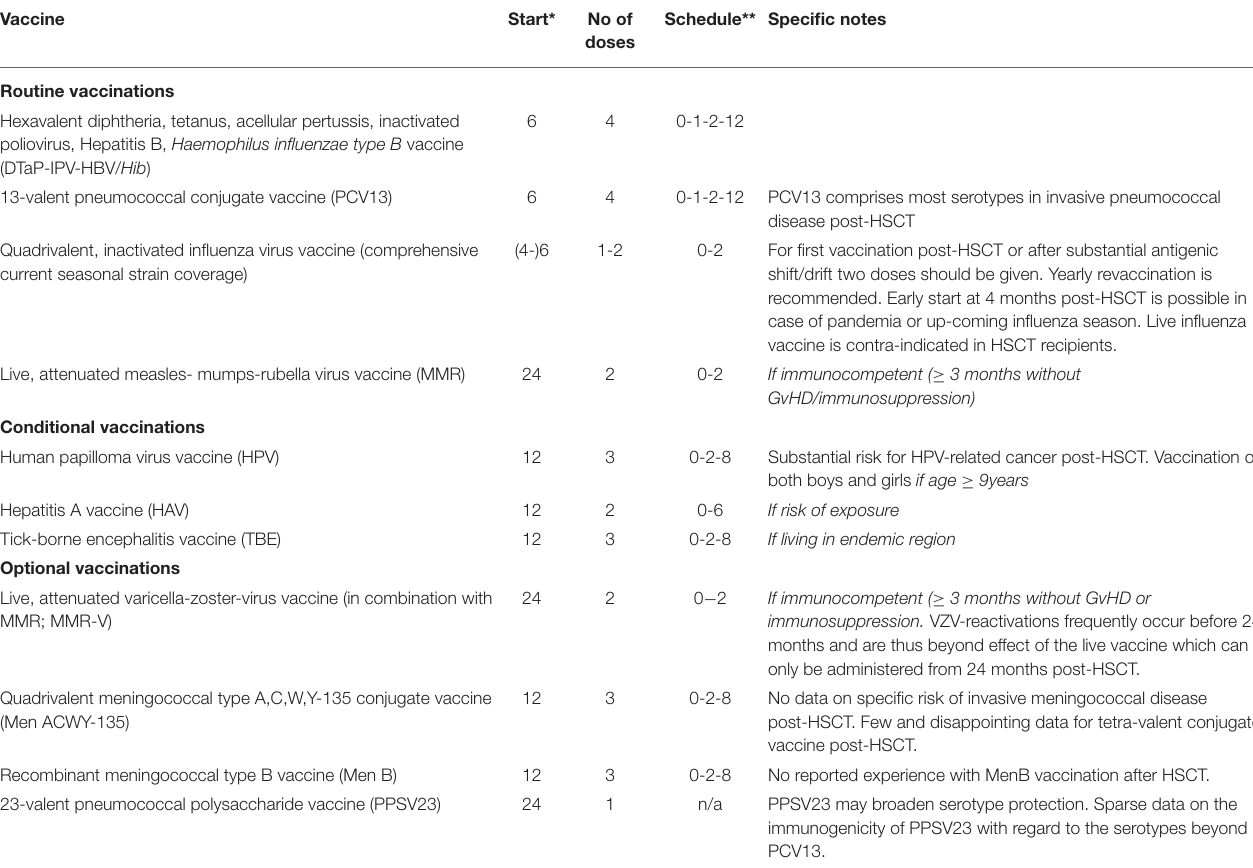
TABLE 4 | Recommendations on specific vaccines following allogeneic hematopoietic cell transplantation in childhood. Vaccine Start* No of